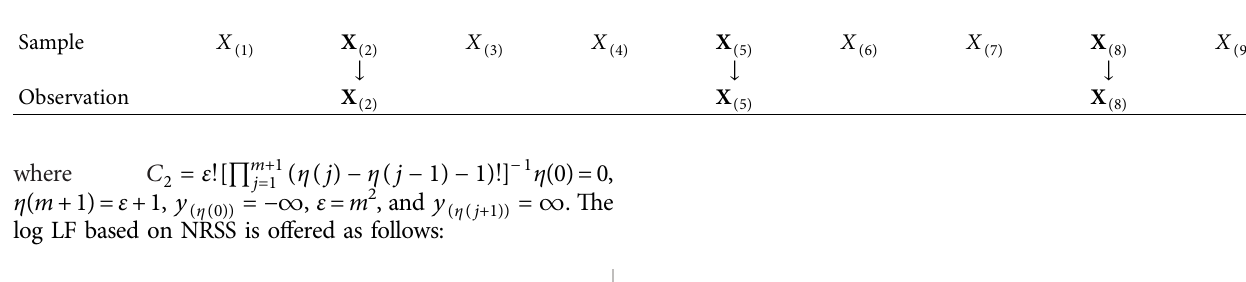
Table 1: Design of NRSS